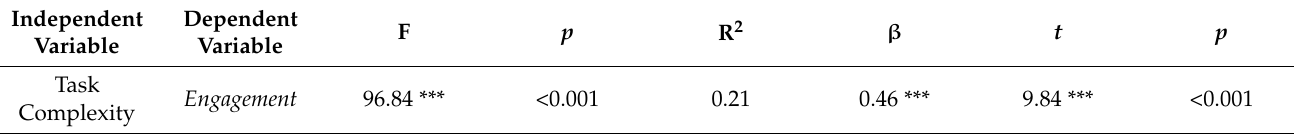
Table 3. Results of simple linear regression (H1).